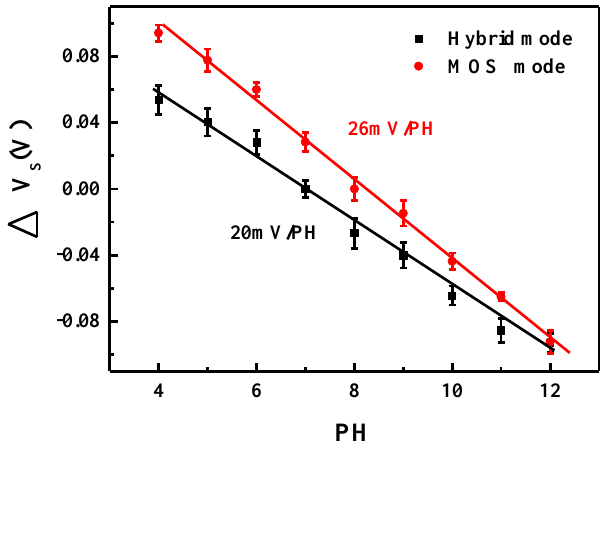
Figure 9. The measured responses of V was biased in the MOS mode (red) and in the hybrid mode